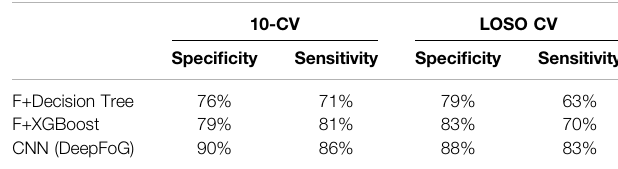
TABLE 2 | Single-wrist comparison of sensitivity/speci fi city pairs for different analysis methodology. F: feature vector consisting of features of Mazilu et al.